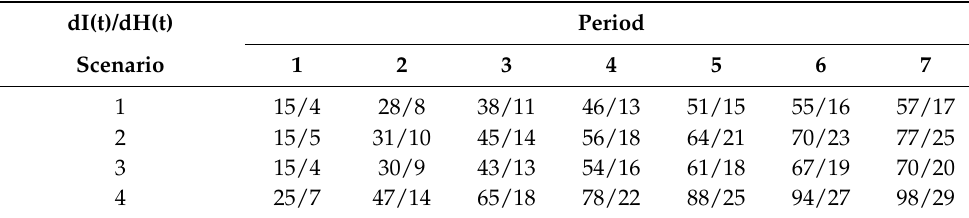
Table 3. Predicted information of Disaster Area